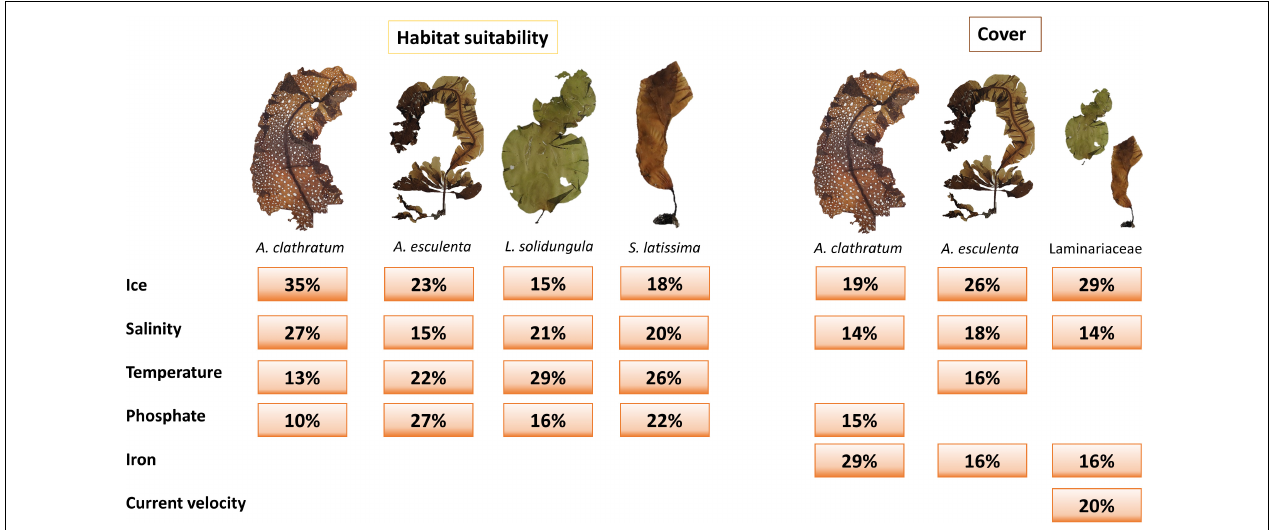
FIGURE 2 | Environmental variable importance (rounded in%, highlighting the% contribution of that variable that explains the modeled distribution) for species and model runs (habitat suitability: Ensemble models, cover: Random Forest). Pictures of the species were taken from the herbarium of the Canadian Museum of Nature (CANA) (details in Supplementary Table 4